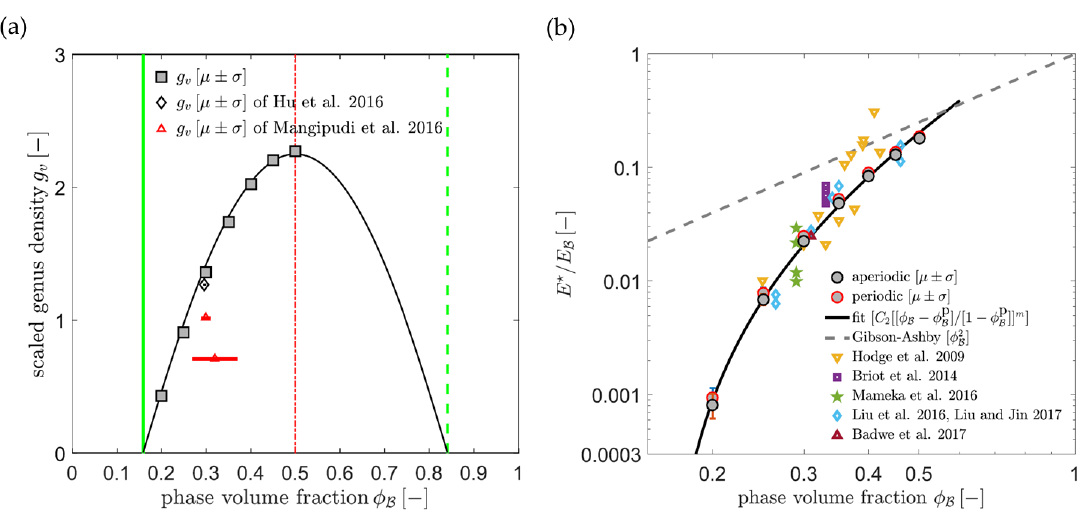
Figure 18. ( a ) Scaled genus density as a function of the solid fraction for structures generated from random Gaussian fields and ( b ) predicted macroscopic Young’s modulus compared to experimental results from the literature. Reprinted from [65] with permission of Elsevier.